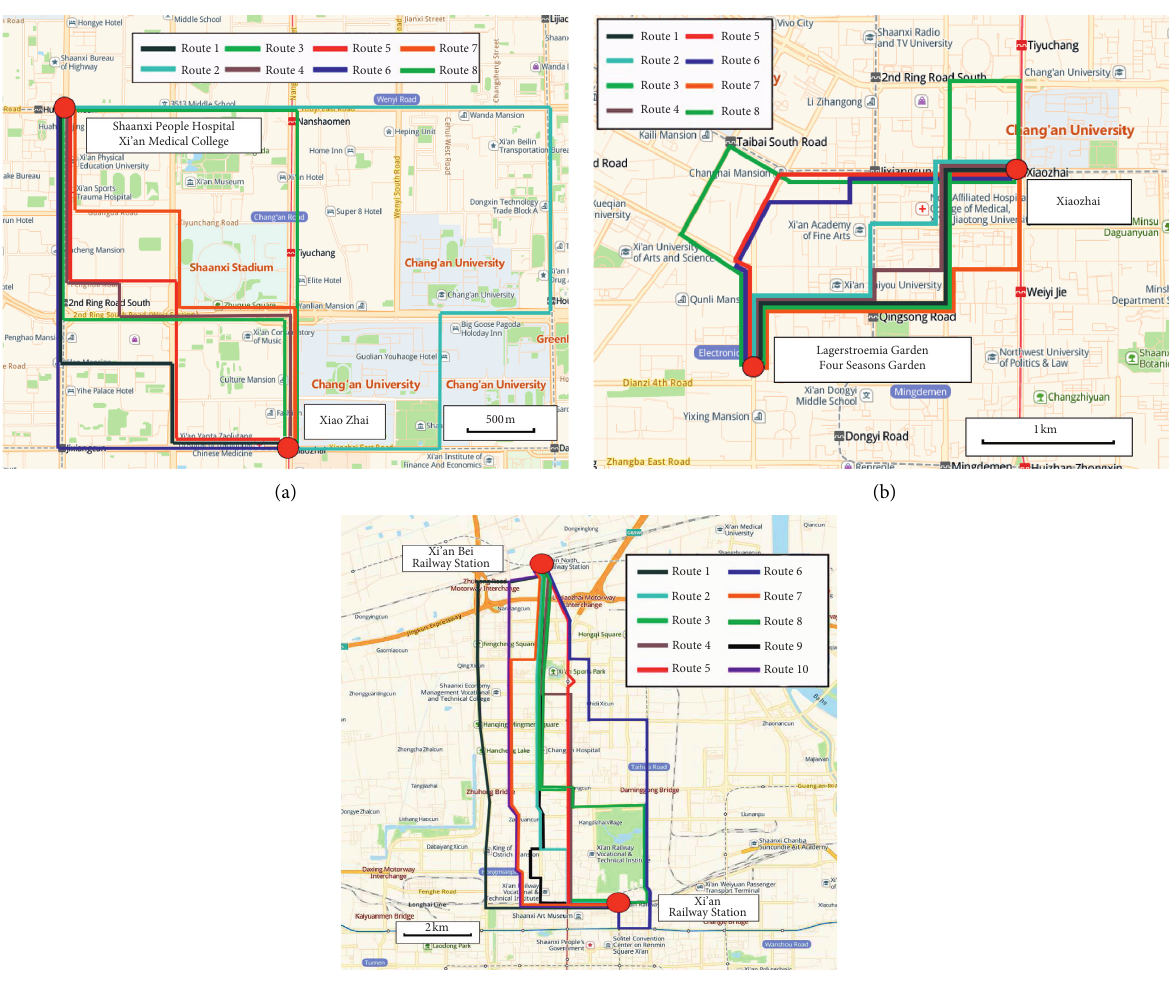
Figure 7: Routes of different passenger-carrying route categories: (a) short-distance passenger-carrying routes, (b) medium-distance passenger-carrying routes, and (c) long-distance passenger-carrying